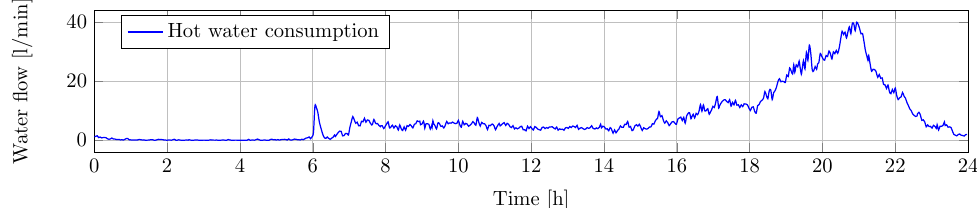
Figure 6. Hot water consumption for the four different scenarios.